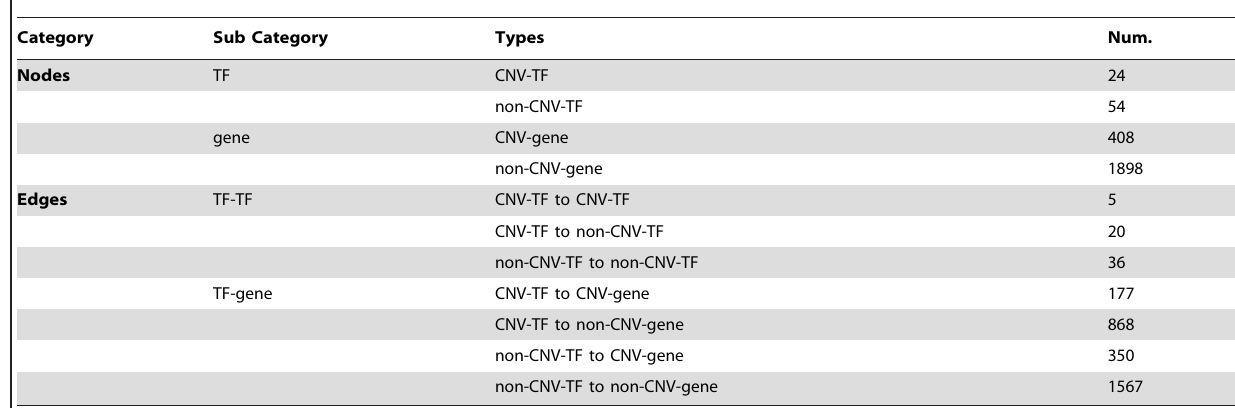
Table 2. Overall statistics about the nodes and edges of CNV-ICC-TRN.